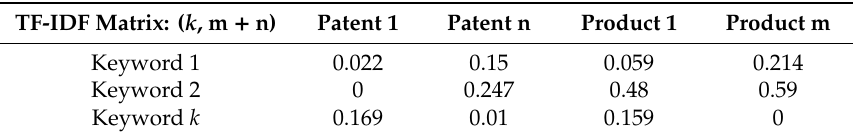
Table 1. Example of a term frequency-inverse document frequency (TF-IDF) matrix based on patents and product